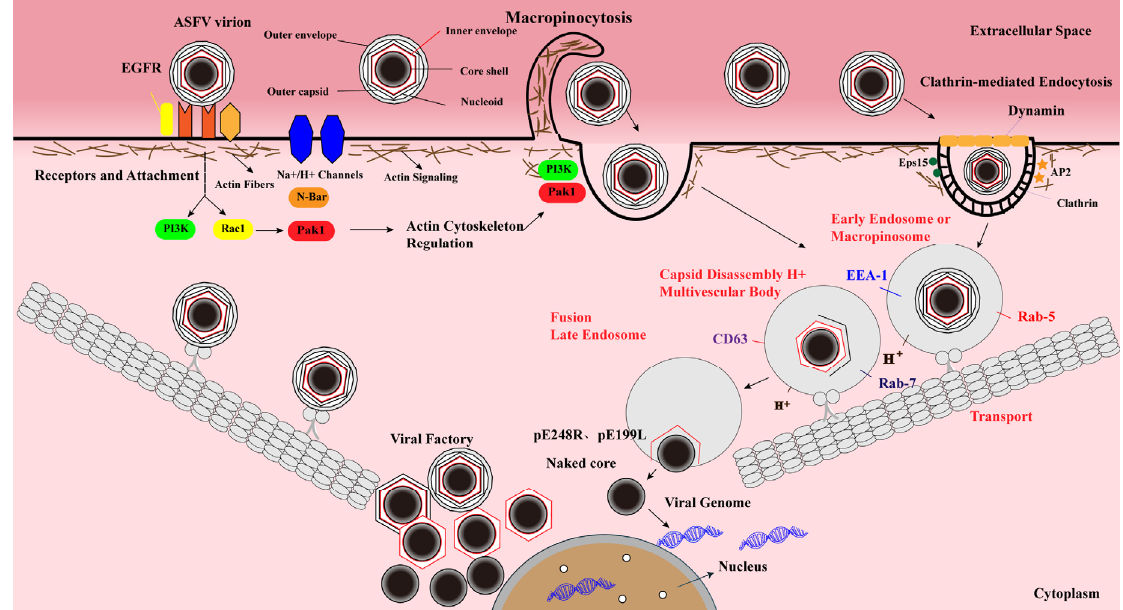
Figure 2. ASFV enters host cells through a complex process involving dynamin- and clathrin-mediated endocytosis (CME) and micropinocytosis. After ASFV entry into the cells via CME and micropinocytosis, the virions are transported from early endosomes to late endosomes along the cytoskeleton, where they undergo an uncoating process characterized by pH-dependent capsid disassembly and disruption of the outer viral envelope. The inner envelope proteins pE248R and pE199L are fused with the endosomal membrane to deliver the genome-containing “naked” cores into the cytosol. Viral genomic DNA replication and virion assembly take place in the viral factories. The newly synthesized virions then move toward the plasma membrane, where they acquire the outer envelope by